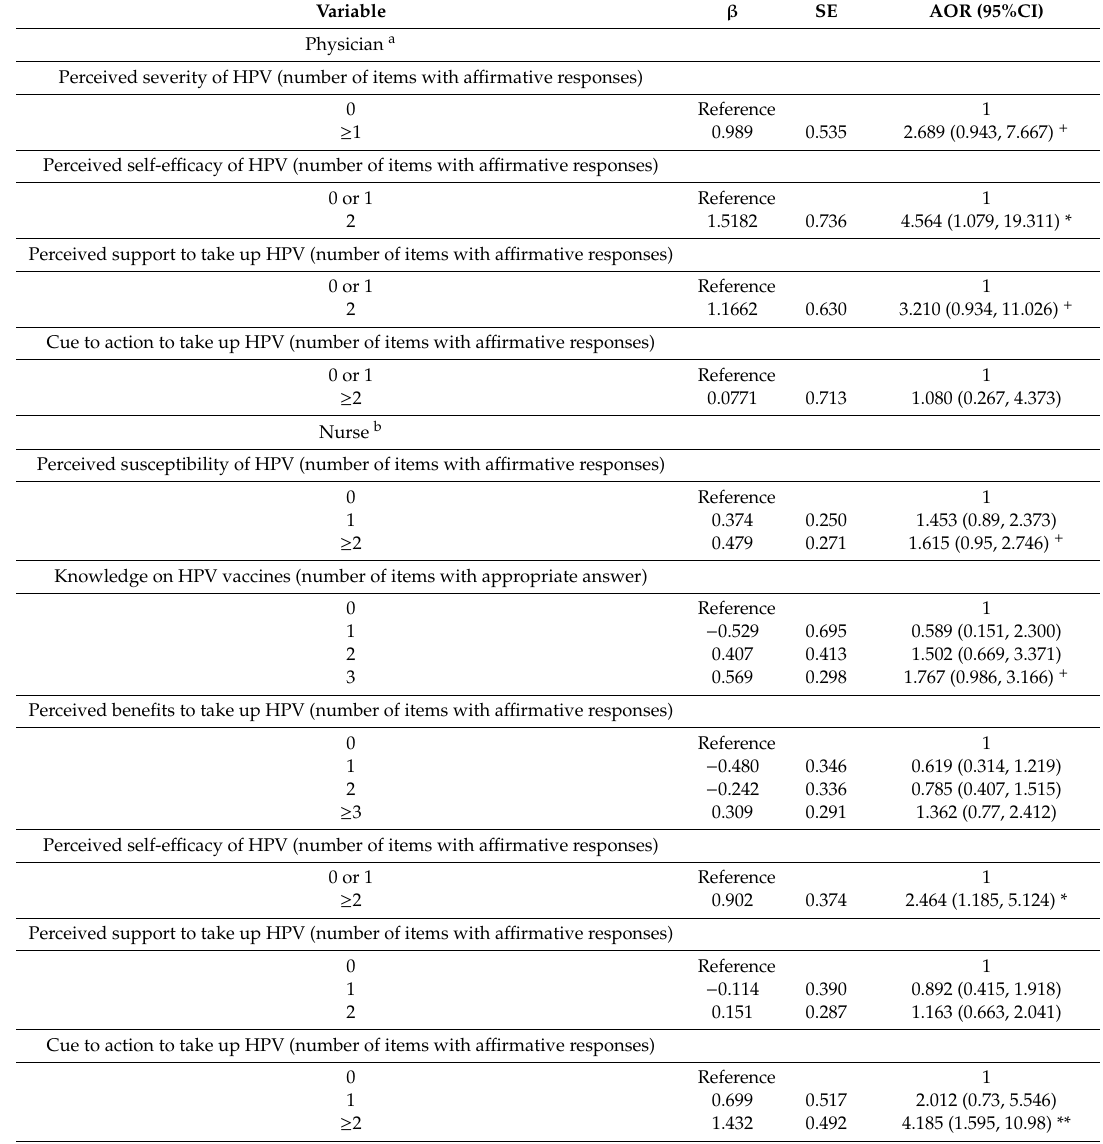
Table 5. Multiple logistic regression result—associations between composite cognitive indicator variables and intention to take up HPV vaccines. Variable β SE AOR